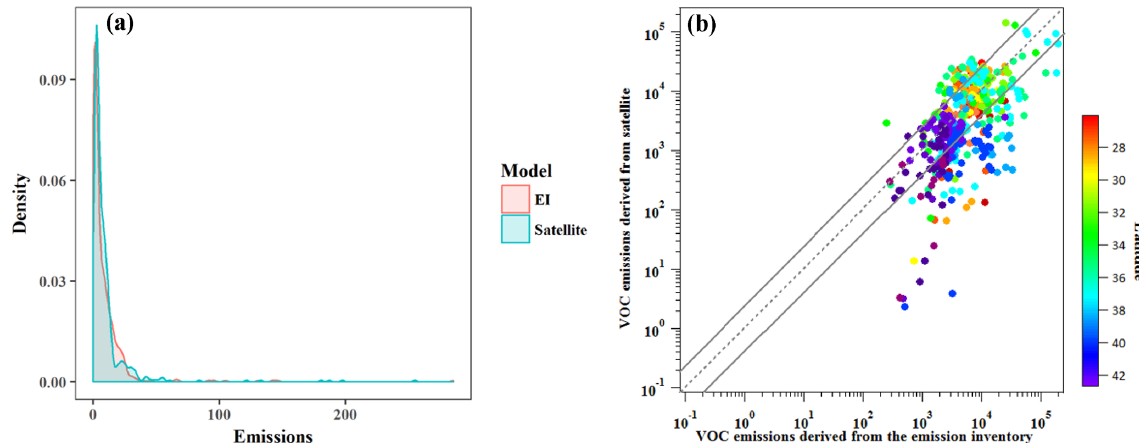
Figure 10. Comparisons between the emissions from the EF-derived emission inventory and the satellite-derived emission